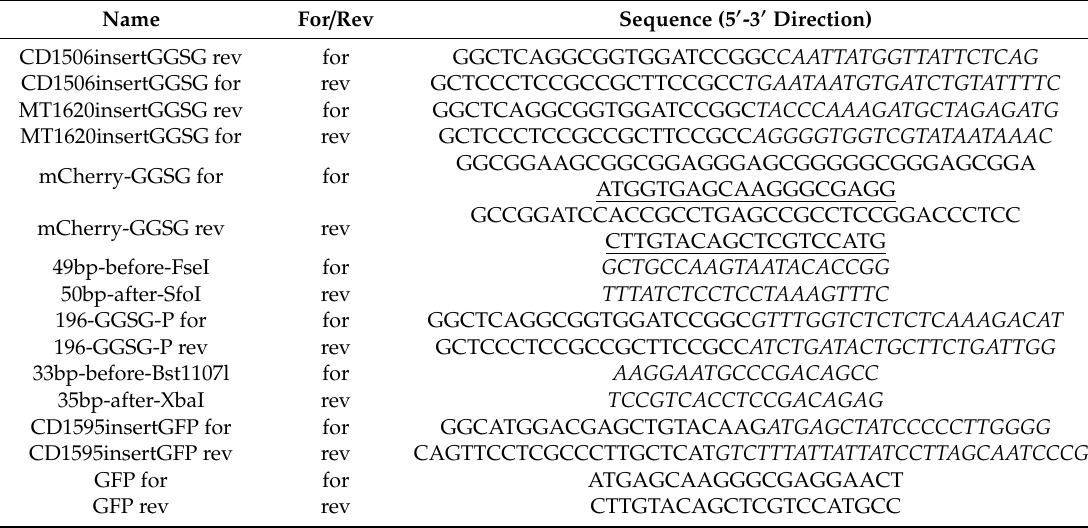
Table 2. Vesicular stomatitis virus (VSV) plasmid cloning strategy primer. italics—L sequence; underline—mCherry